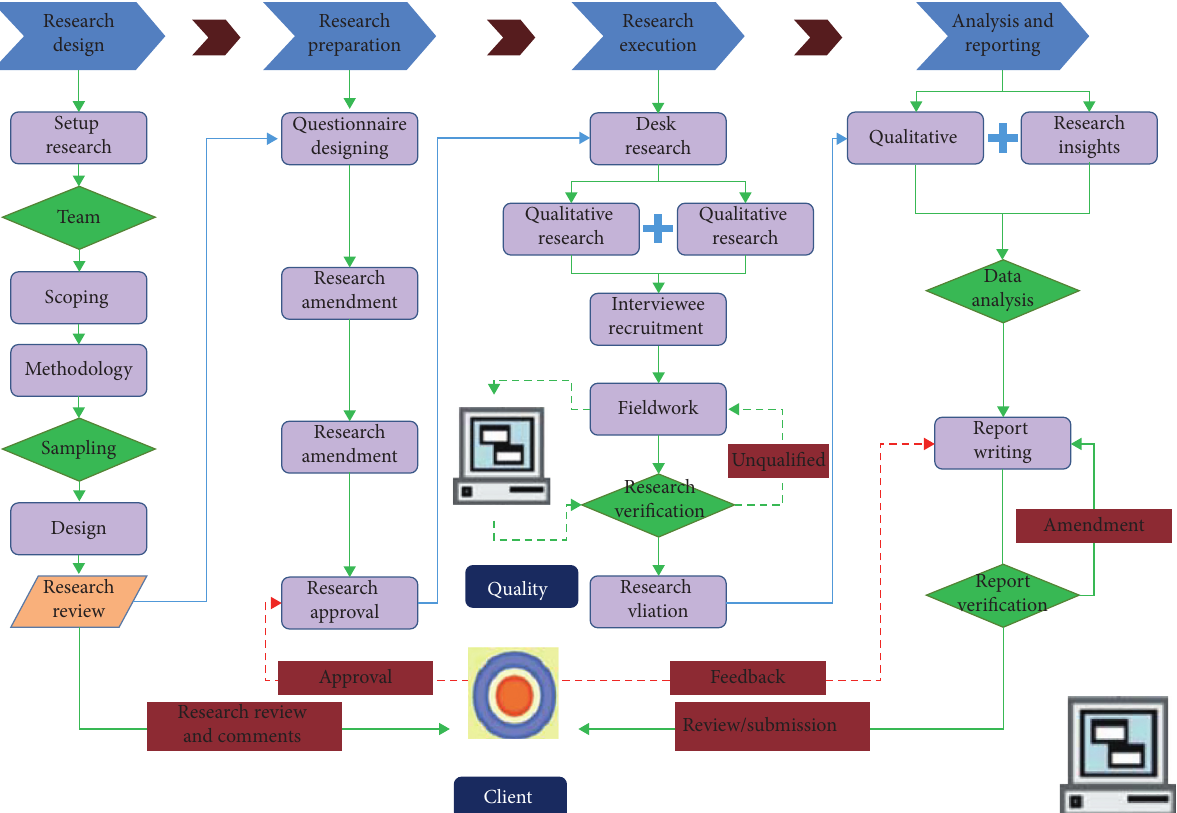
Figure 1: Optimized model of an HR scheduling